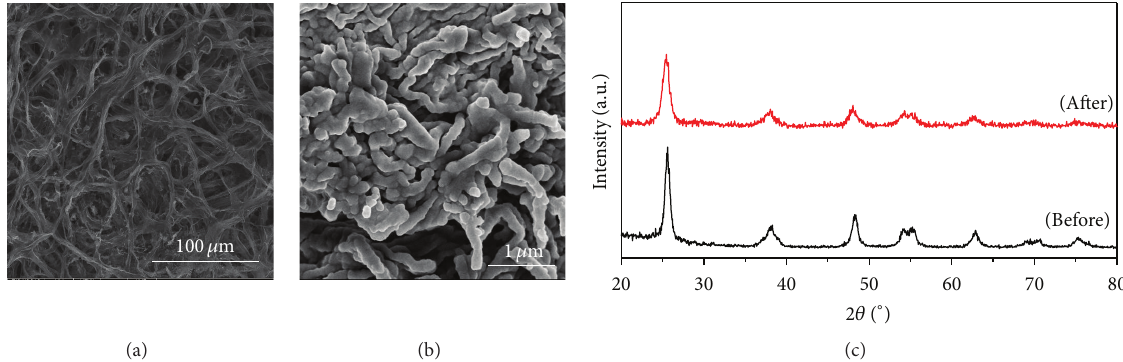
Figure 8: (a) Low magnified and (b) large magnified SEM images of porous TiO 2 nanotubes after photocatalytic reaction for MO. (c) XRD patterns of porous TiO 2 nanotubes before and after photocatalytic degradation for